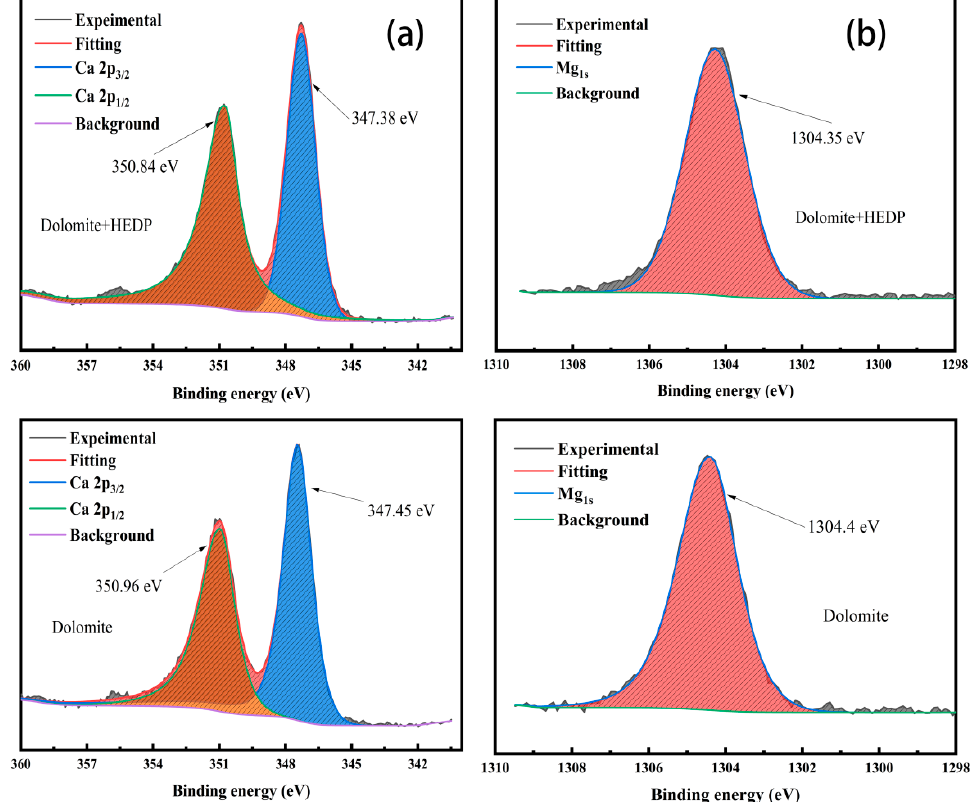
Figure 11. XPS spectrum of Ca 1s ( a ) and Mg 1s ( b ) for dolomite before and after the interaction with HEDP.